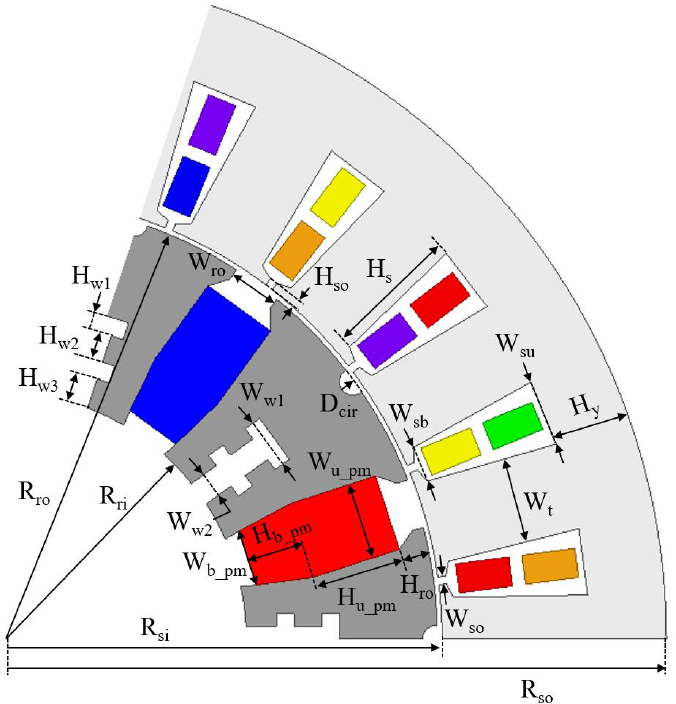
Figure 13. Geometrical parameters of the proposed 6Φ -SS-FSCW-Fer-SIPMSM.